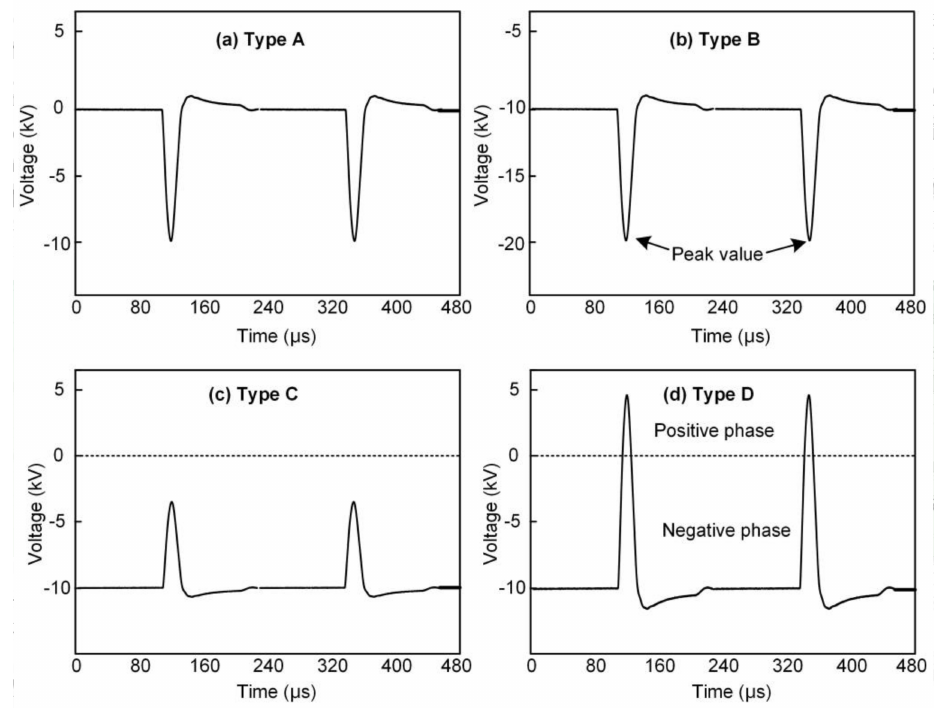
Figure 2. Different types of combined direct current (DC)-pulse voltage with negative DC: ( a – d ) typical combined voltage of types A, B, C and D,